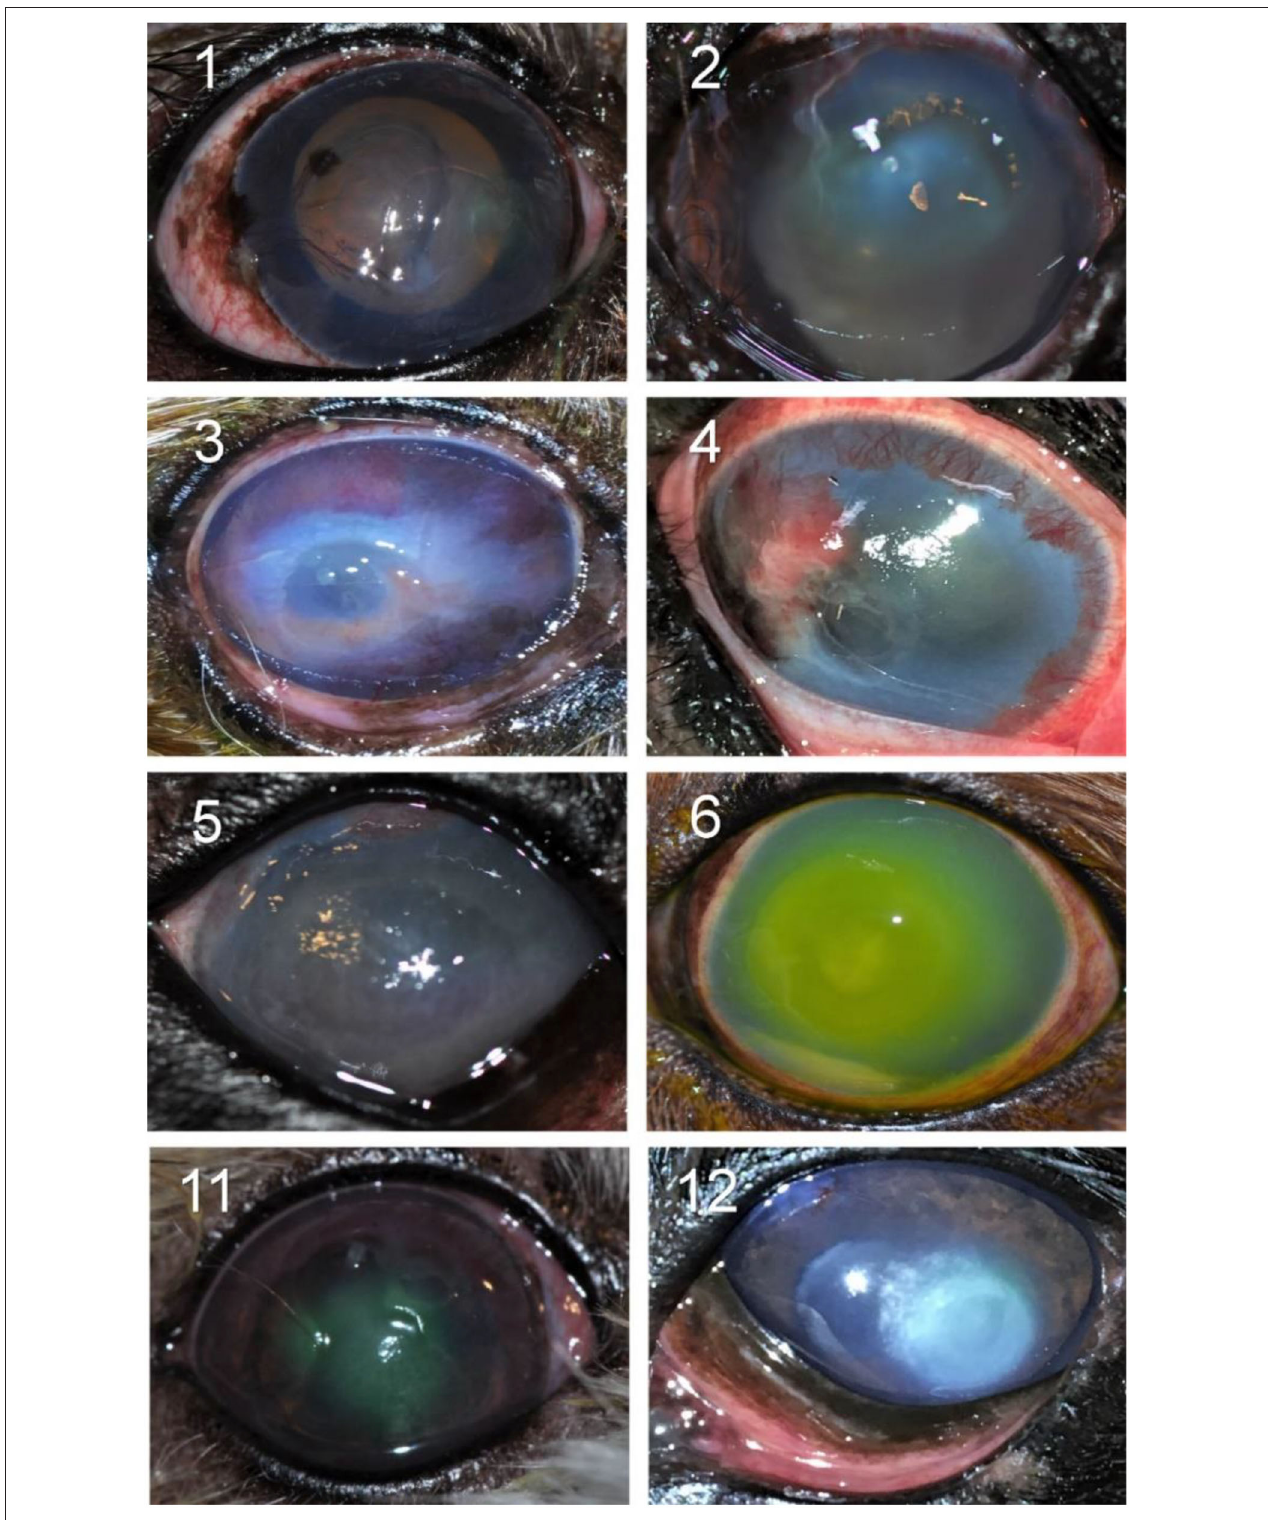
FIGURE 2 | Clinical photographs of canine eyes diagnosed with culture-confirmed bacterial keratitis. Patients ID are shown in the top left (see Table 1 for additional details).